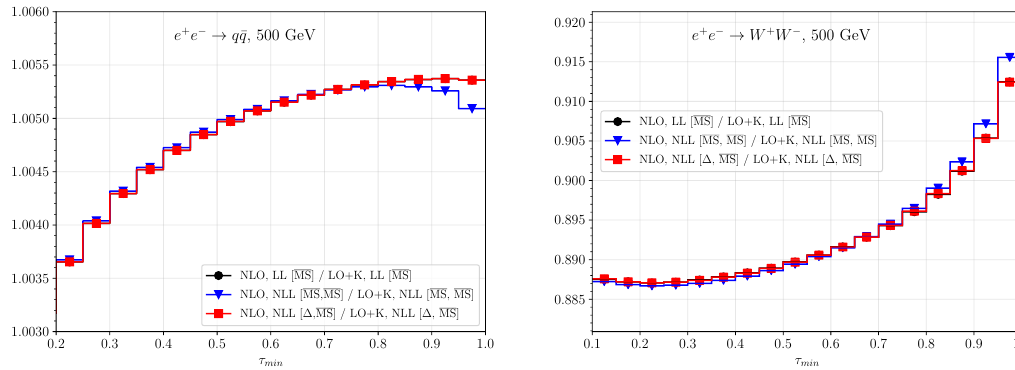
Figure 12 . K-factors computed by including the contribution stemming from eq. (B.3) in the LO cross sections, in the MS renormalisation scheme for both NLL PDFs (in the MS and ∆ factorisation schemes) and LL PDFs. Left panel: q ¯ q production; right panel: W + W − production.